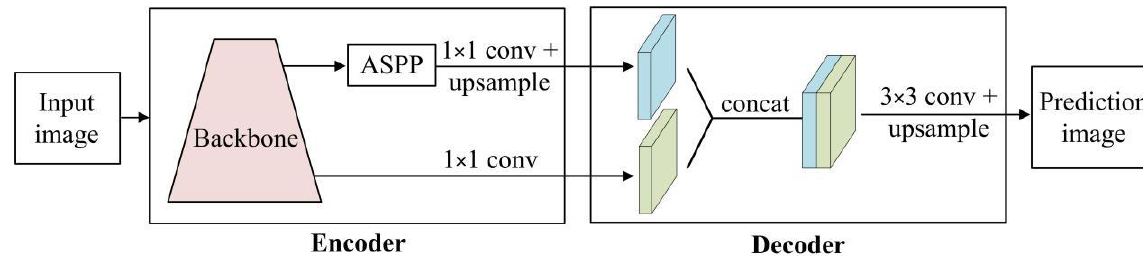
Figure 4. Architecture of DeeplabV3+.